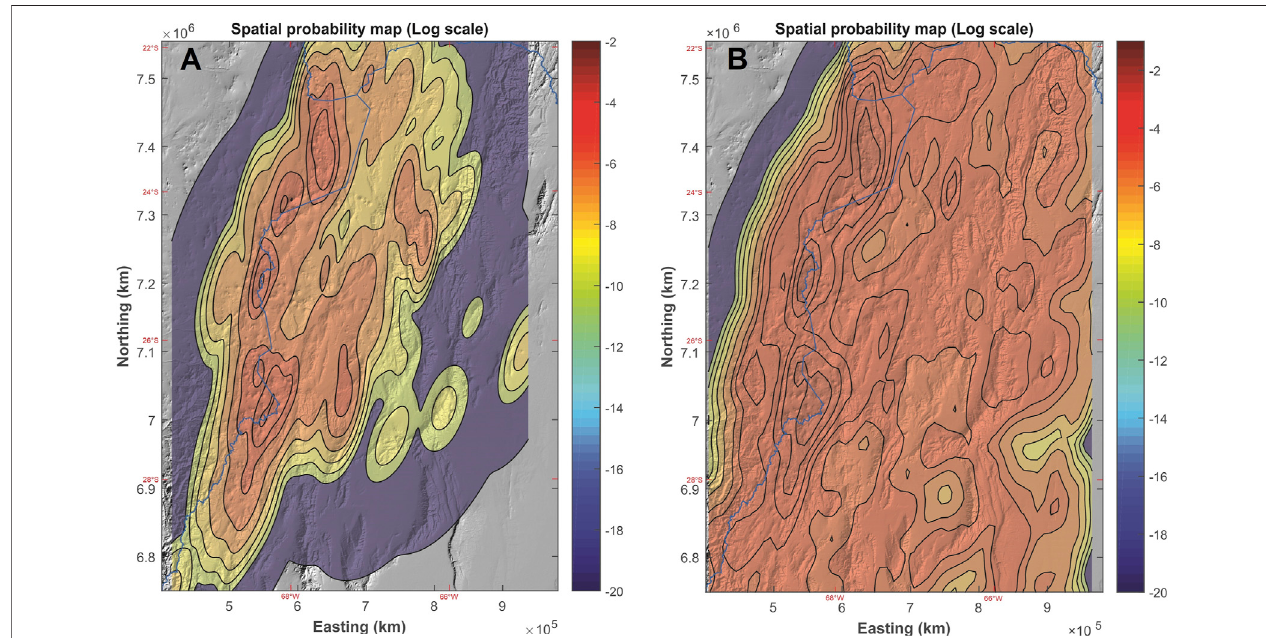
FIGURE 11 | Spatial probability analysis considering: (A) volcanic events, and (B) volcanic events (80%) and structural data (20%). Probability density functions were obtained after applying the kernel density estimation method, and are shown as probability isocontours on a logarithmic scale to illustrate order-of-magnitude changes. The political border between Chile, Argentina and Bolivia is depicted for reference (blue line). ASTER Digital elevation model used as a background image follows a greyscale colour scheme: the whiter the pixel, the higher the elevation.